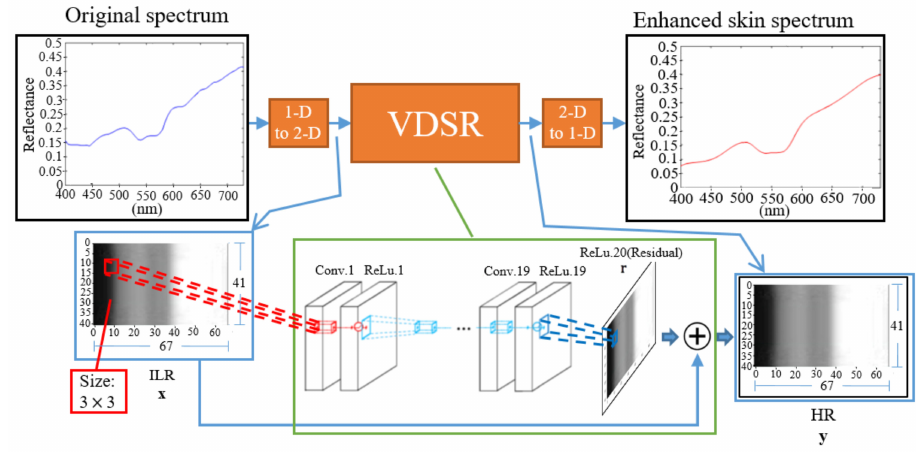
Figure 6. Proposed VDSR network architecture.